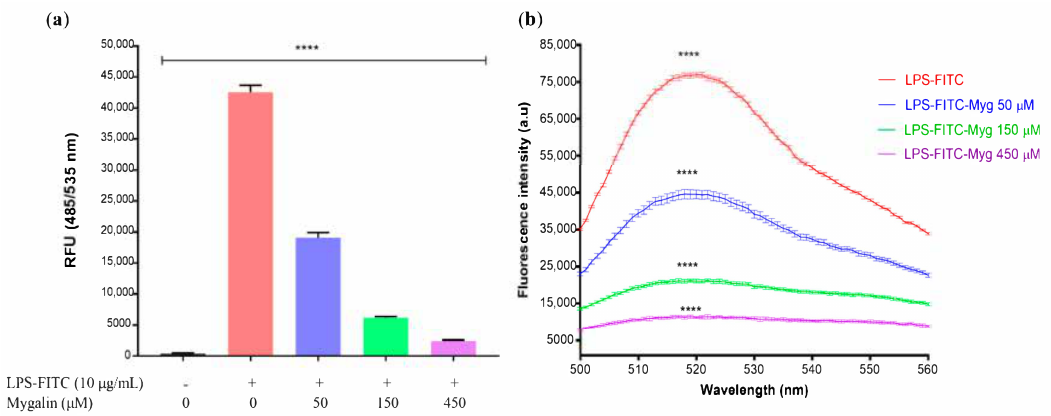
Figure 9. Mygalin binds to LPS. To demonstrate the binding of mygalin to LPS, di ff erent